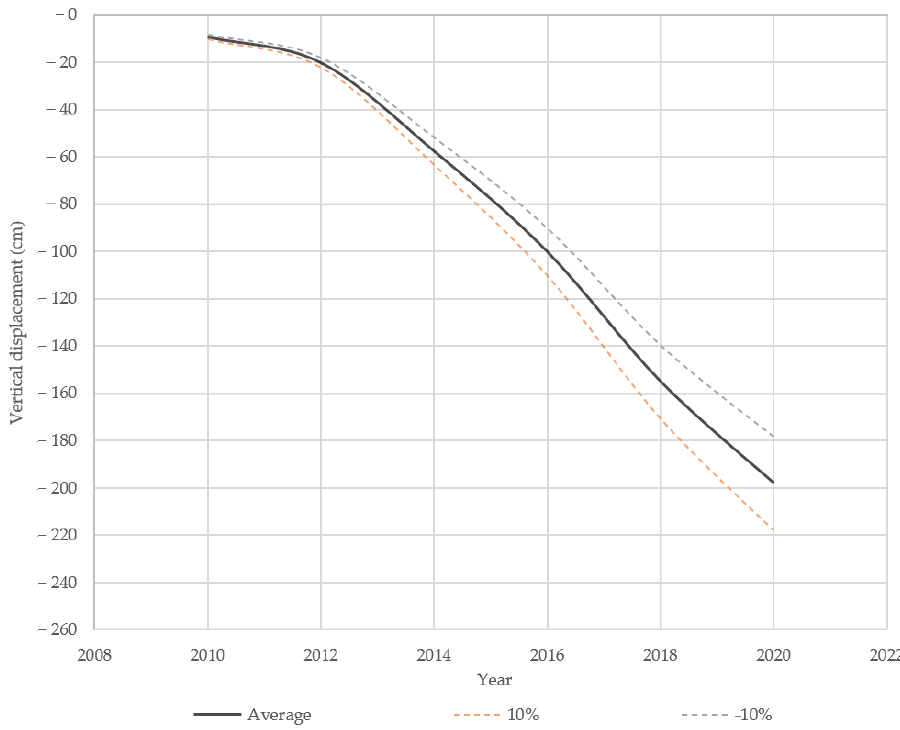
Figure 9. Average subsidence profile together with a 90% confidence level.